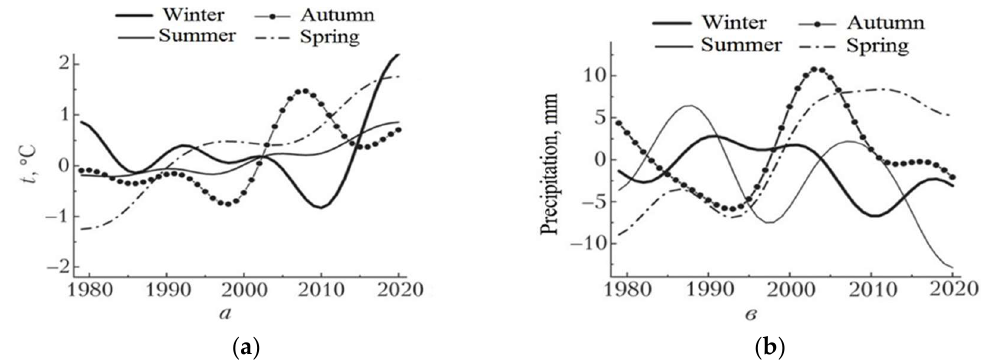
Figure 4. Inter-annual variability of smoothed values of average annual seasonal anomalies of ( a ) air temperature and ( b ) precipitation in Western Siberia. Modified from [76]. Winter = December,